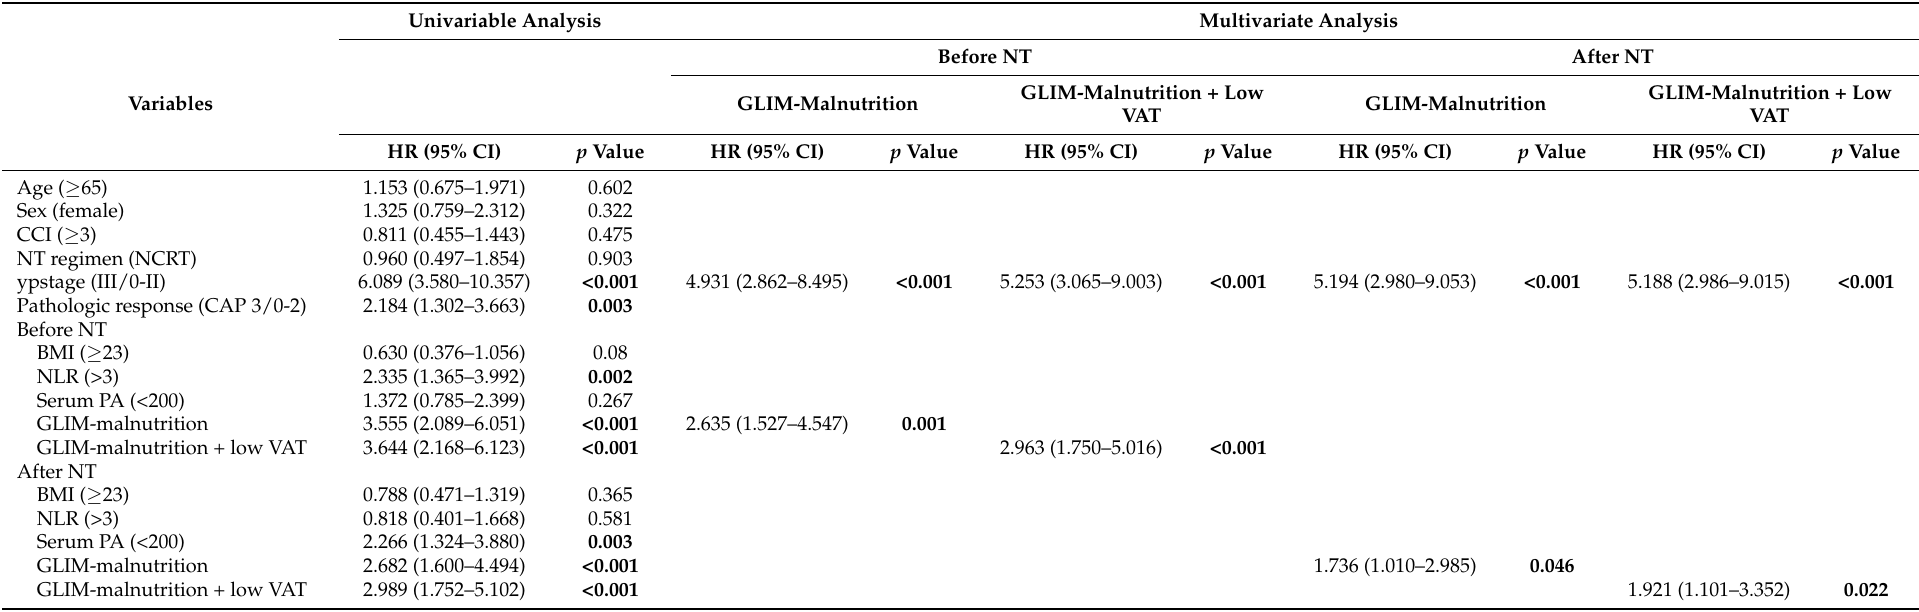
Table 5. Univariate and multivariate analysis for prognostic factors for overall